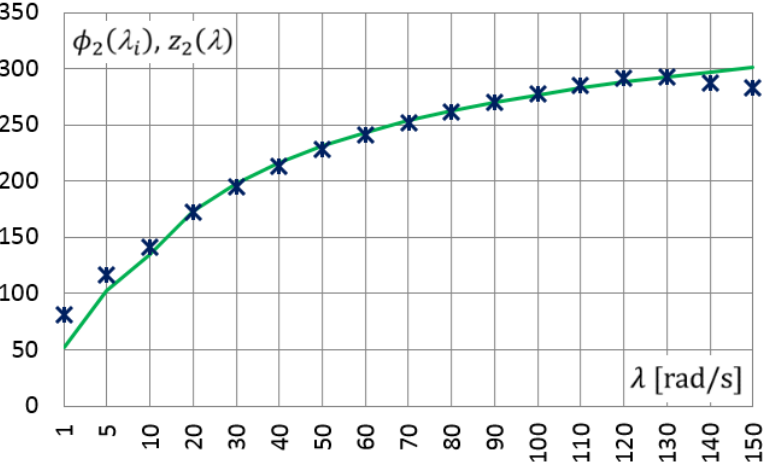
Figure 11. Functional relationships for selected frequencies: φ 2 ( λ i ) —obtained from laboratory test (points), z 2 ( λ ) —derived for Zener model (solid